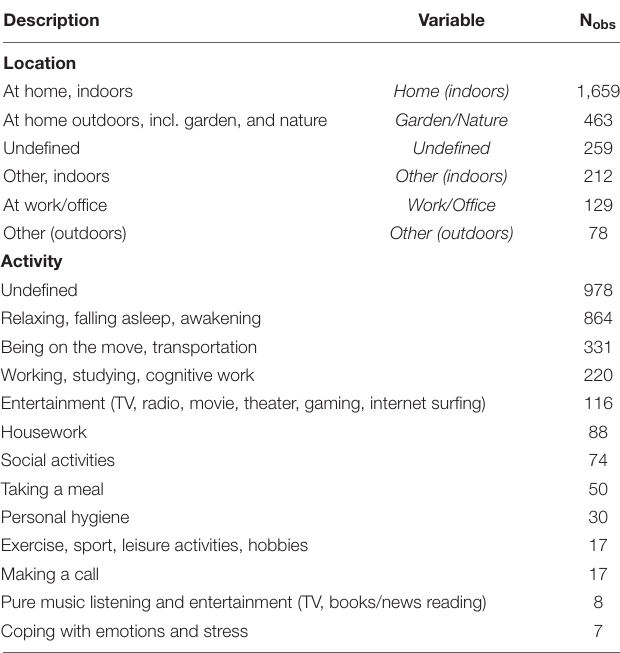
TABLE 1 | Categories used for the variables Location and Activity .